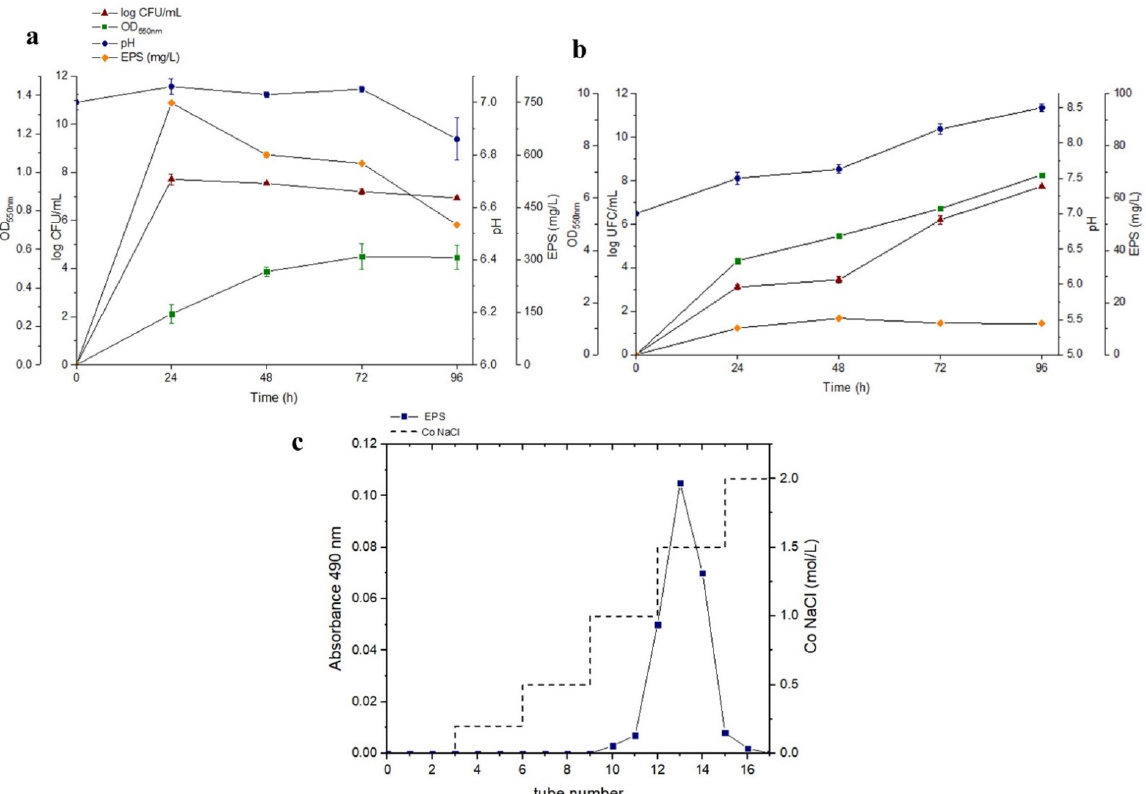
Figure 1. ( a ) Analysis of bacterial growth, CFU/mL, pH and EPS production in MGM with glucose. ( b ) Analysis of bacterial growth, CFU/mL, pH and EPS production in an enriched medium. ( c ) Elution curve obtained from purification of EPS t extracted from bacteria grown on MGM with glucose.